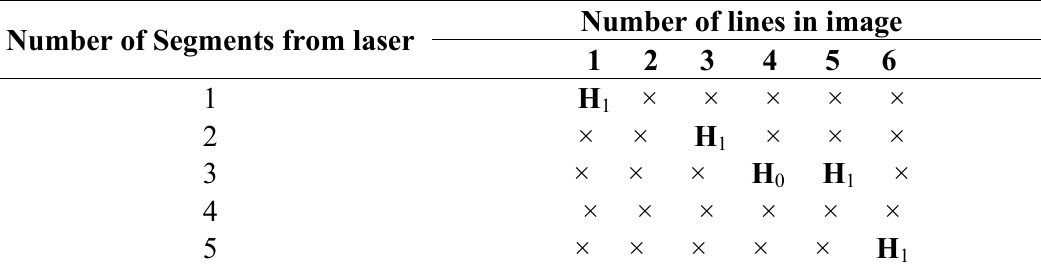
Table 2. The hypothesis test of feature fusion.